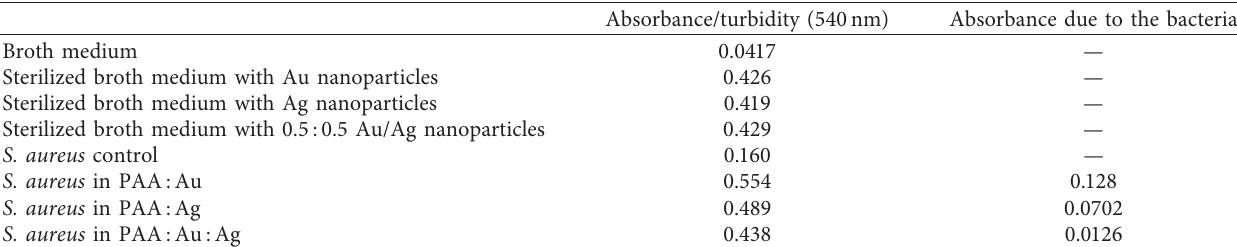
Table 2: UV-visible absorbance for broths treated with S. aureus